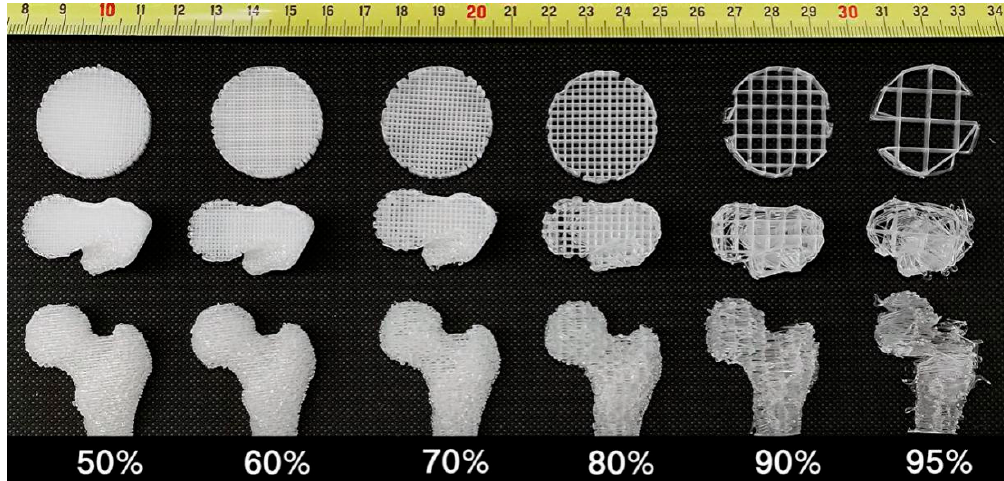
Figure 10. From left to right, images of scaffolds with 50%, 60%, 70%, 80%, 90%, and 95% porosities generated by fused deposition modeling (FDM) technology. Top and bottom rows show the scaffolds 3D printed using the disk model and anatomically-shaped femur model, respectively. The middle row shows the internal structures of the scaffolds of the bottom row.